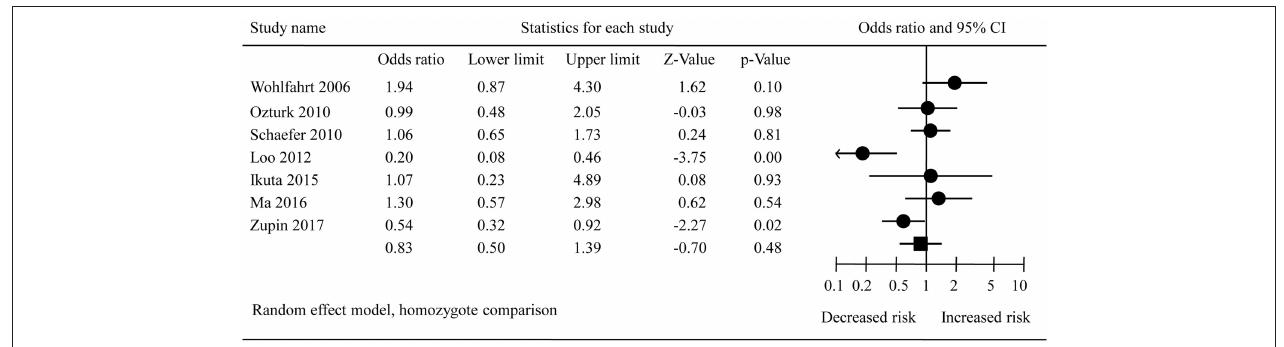
FIGURE 2 | Forest plot of overall analysis in homozygote comparison. CI, Confidence interval.